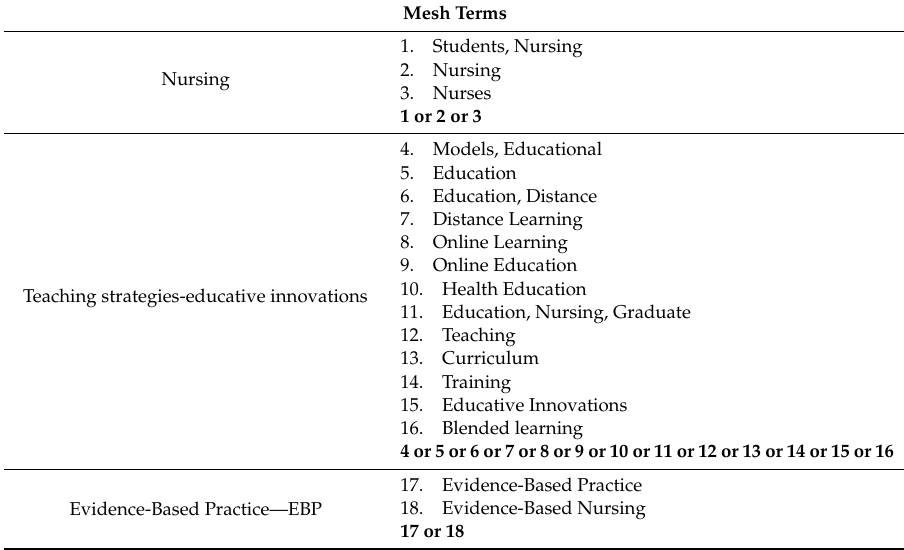
Table 1. Search strategy used for the